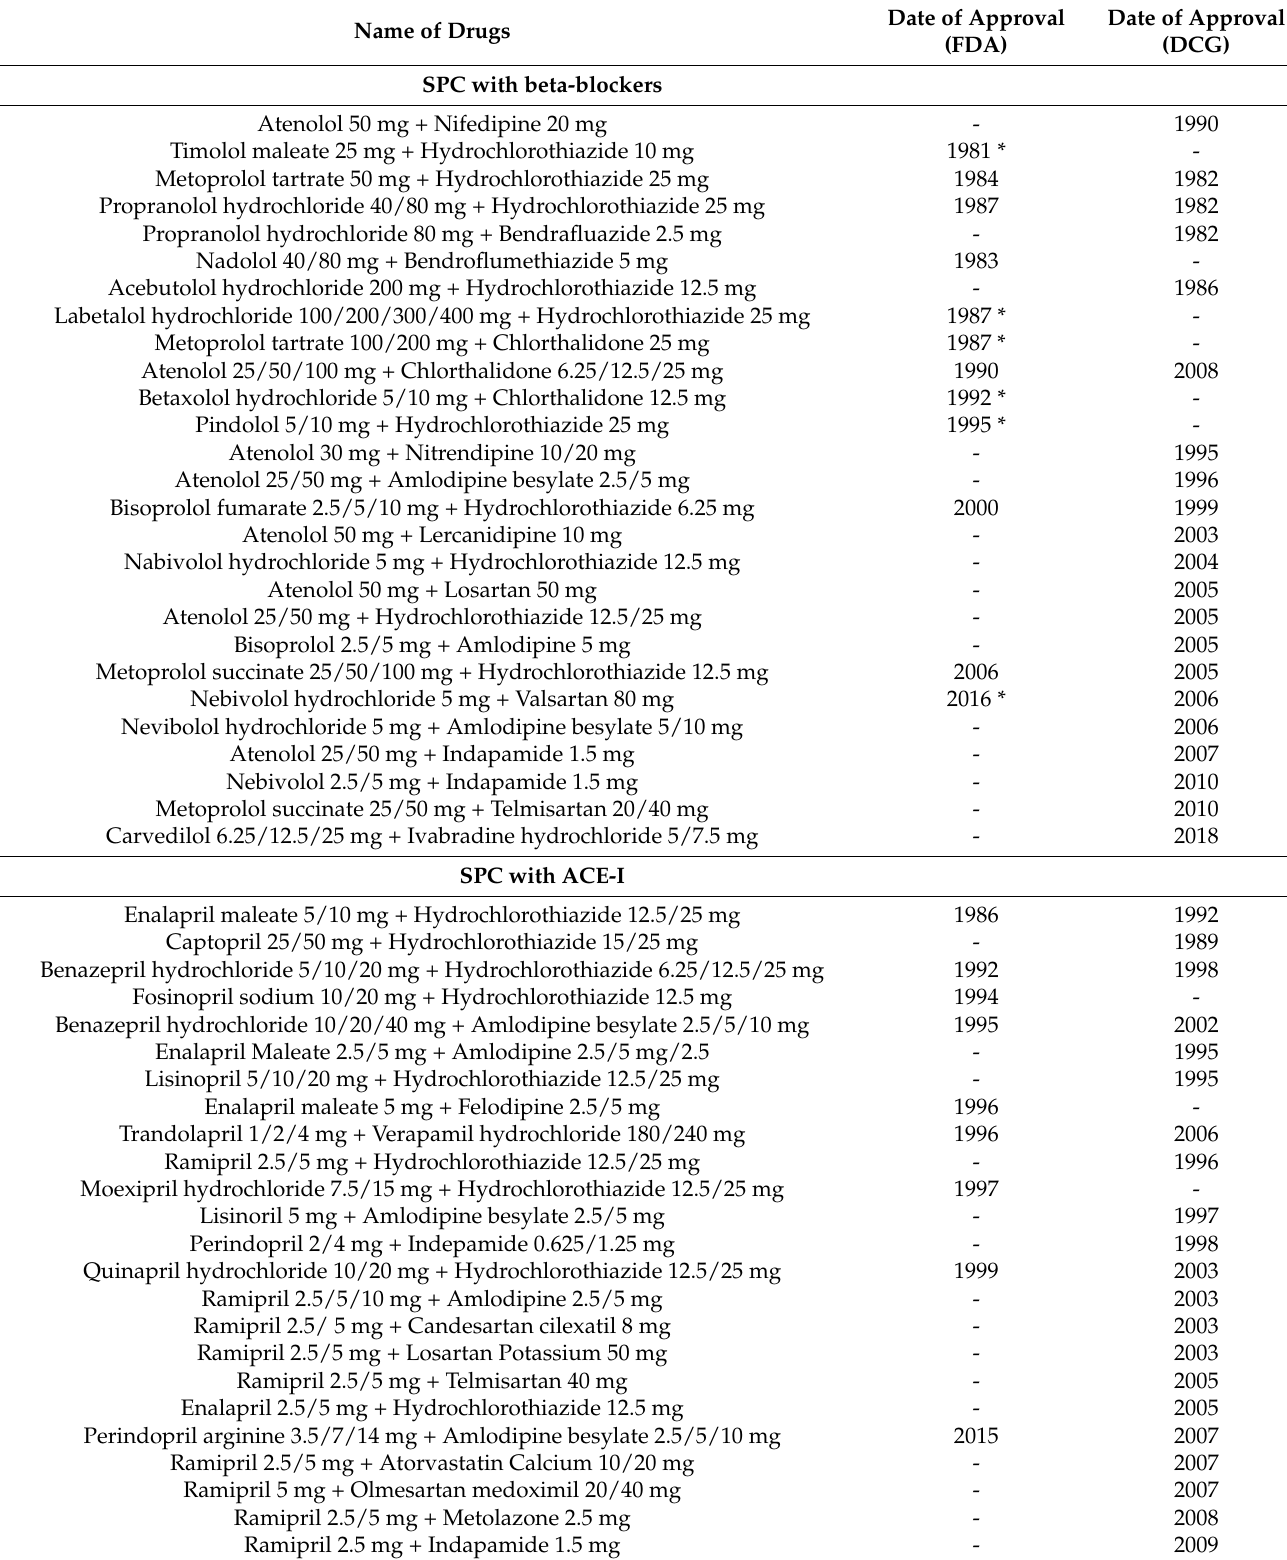
Table 4. Approved drugs with beta-blocker or ACE-I and beta-blocker with ACE-I